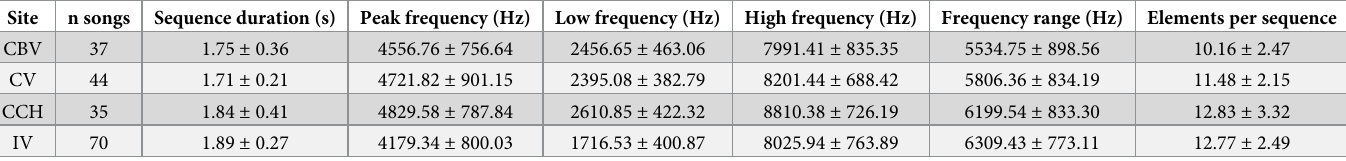
Table 3. Summary of mean ( ± sd) T . browni song traits for each study site. Site